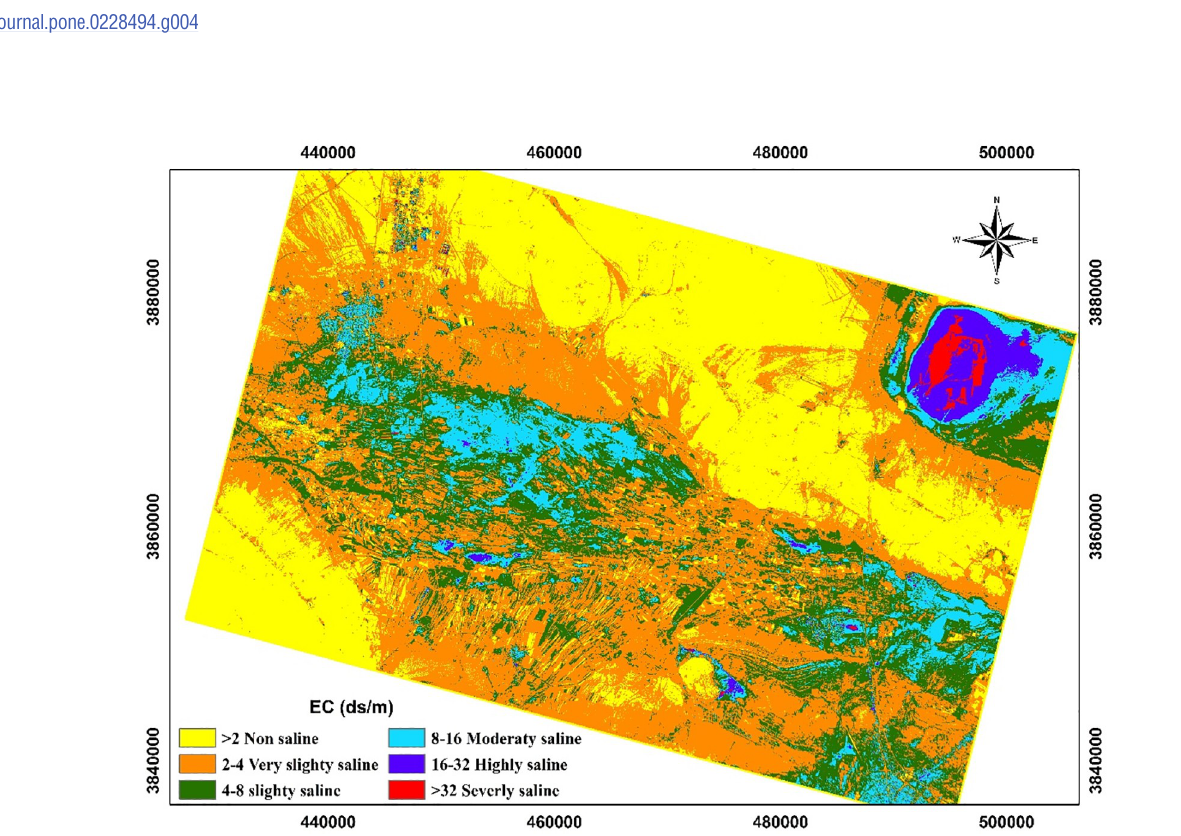
PLOS ONE | https://doi.org/10.1371/journal.pone.0228494 May 13,